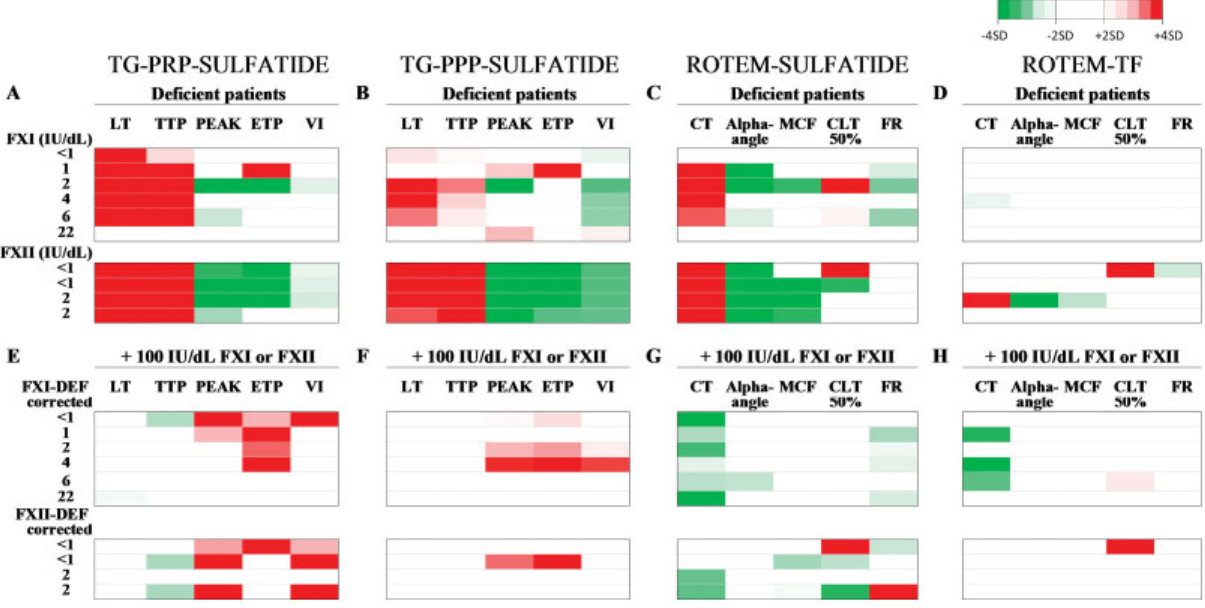
Fig. 5 Comparative analysis of alterations in thrombin generation and thromboelastometry for individual patients. Colormaps of relevant increased ( red ) or decreased ( green ) values of indicated curve parameters of thrombin generation in PRP ( A and E ), thrombin generation in PPP ( B and F ), and thromboelastometry ( C – D and G – H ). Altered values were considered to be relevant, if outside the range of mean (cid:6) 2 SD of values from the control group ( white ). Borders for conditional formatting are mean (cid:6) 2 SD and mean (cid:6) 4 SD. Individual patients were ordered per line, ranking from higher to lower de fi ciency (factor levels indicated). Basal values ( upper panels ) and effects of factor repletion ( lower panels ) after triggeringwithsulfatides orTFasindicatedinthe fi gure ( C ). α -angle, rate ofclot formation; CLT 50%, clot lysistime calculatedasthe interval from 50% clot formation to 50% clot lysis (s); CT, clotting time (s); ETP, endogenous thrombin potential (nM min); FR, fi brinolysis rate between lysis- onset time (LOT at 15% reduction of MCF) and lysis time (LT at 90% reduction of MCF) (% decline/min); LT, lagtime (min); MCF, maximal clot fi rmness (mm); PEAK (mm); PPP, platelet-poor plasma; PRP, platelet-rich plasma; SD, standard deviation; TTP, time to peak (s); VI, velocity index